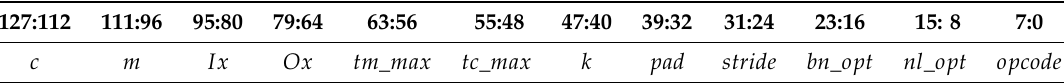
Table 2. Instruction